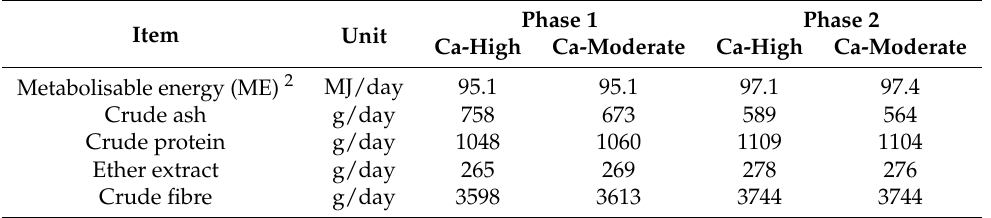
Table 4. Energy and crude nutrient supply 1 per stallion per day in the two experimental phases, categorised by